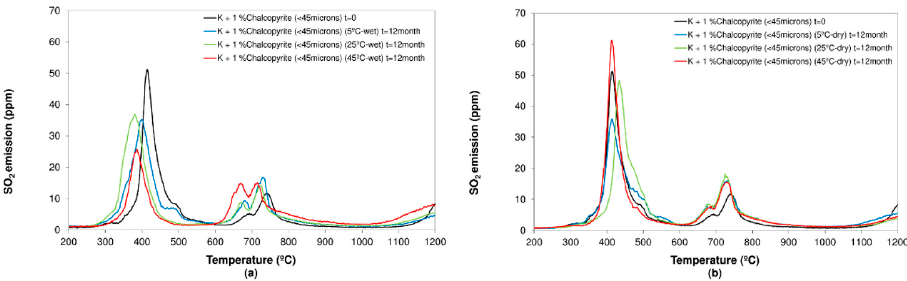
Figure 3. Evolution of the sulfur dioxide emission of the chalcopyrite composition in ( a ) a wet environment and ( b ) a dry environment.